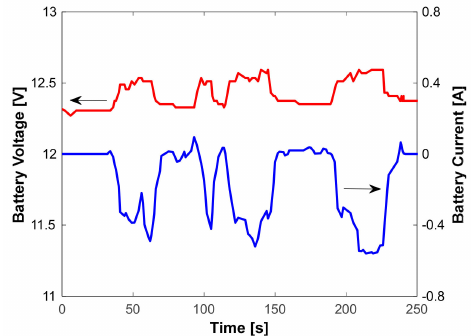
Figure 8. Battery voltage and battery current versus time during charging operations performed through wind generation